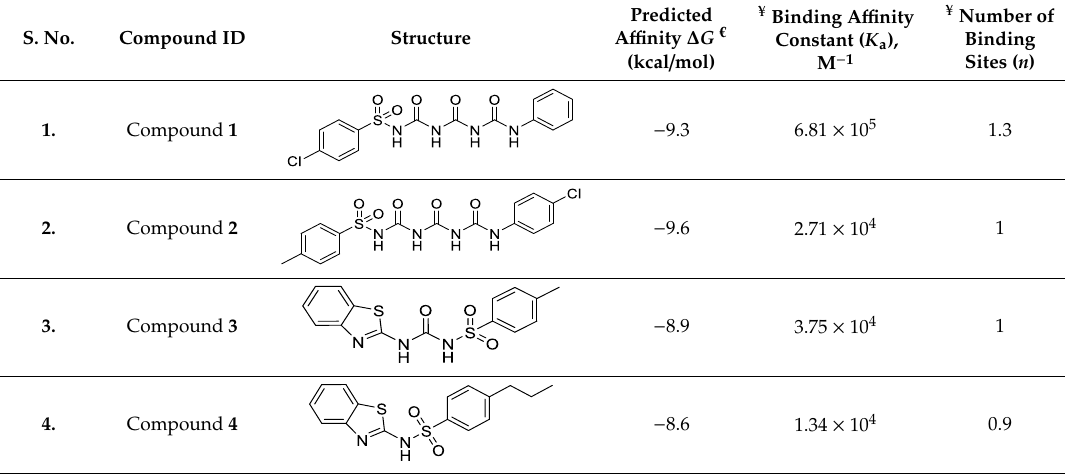
Figure 5. Binding studies of Compounds 6 , 7 , and 8 with SphK1. Fluorescence emission spectra representing SphK1 with the addition of ( A ) Compound 6 (0–0.92 μM), ( B ) Compound 7 (0–0.5 μM), and ( C ) Compound 8 (0–26.1 μM). SphK1 was excited at 280 nm, and emission spectra were recorded in the range of 300–400 nm. Modified Stern–Volmer plot showing quenching of SphK1 fluorescence with increasing concentrations of ( D ) Compound 6 , ( E ) Compound 7 , and ( F ) Compound 8 . Table 1. Binding parameters of all the synthesized compounds with SphK1 obtained from molecular docking and fluorescence binding studies.